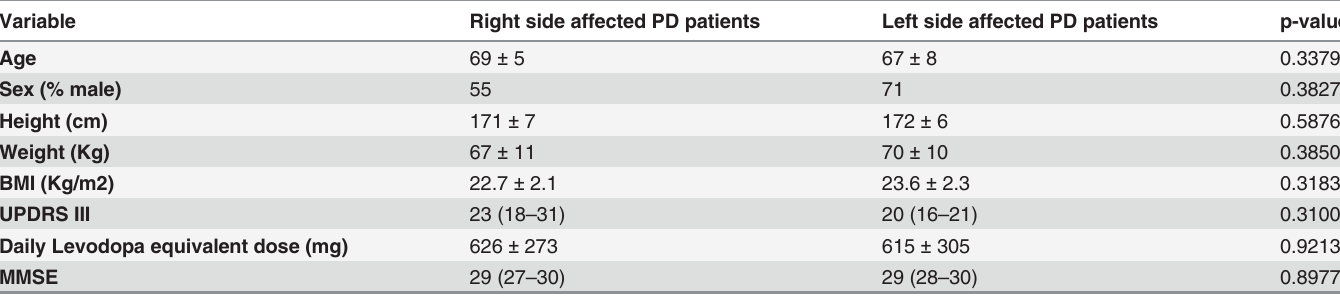
Table 2. Comparison between right affected and left affected PD